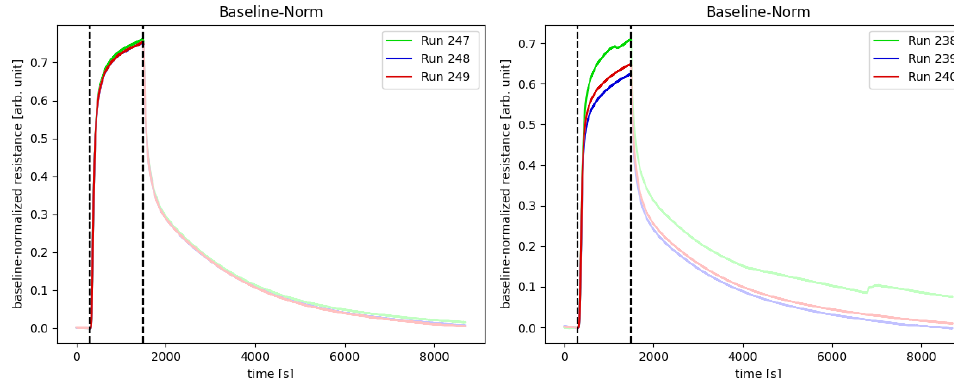
Figure 7. Second and third place of the final ranking.